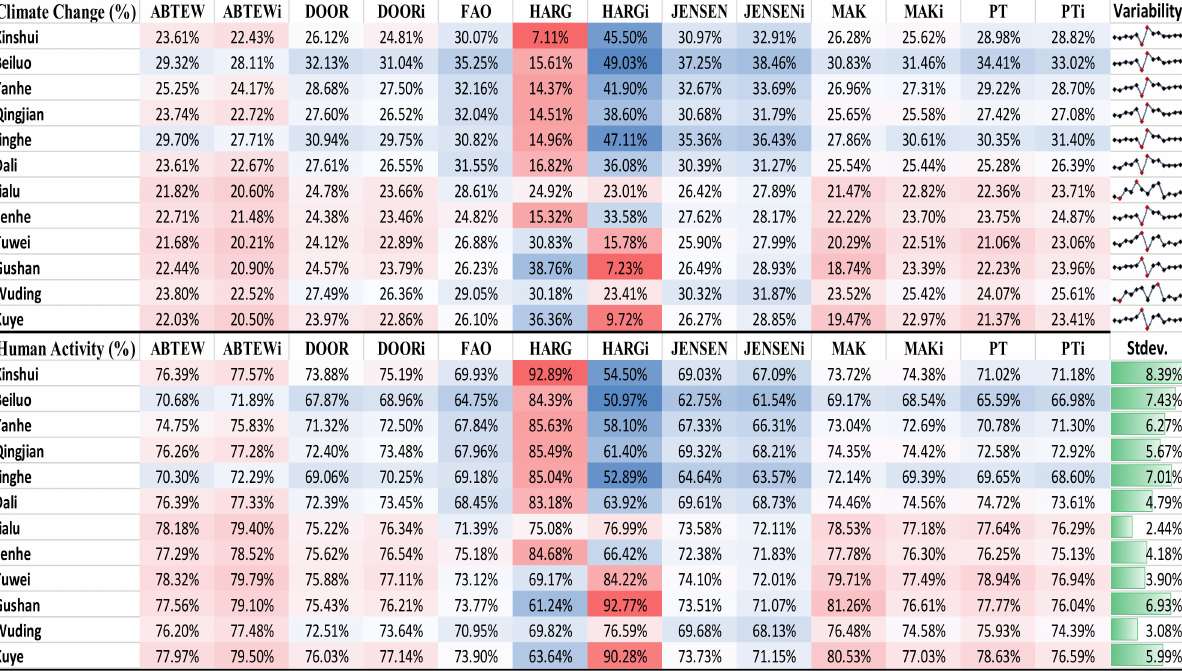
Figure 5. Quantitative contribution to streamflow change by climate change (%) and human activities (%): for each type of 13 E 0 estimations, contribution values are averaged over results calculated with eight Budyko-based methods; at the catchment scale, the variability (line plot) and standard deviation (bar plot) of contribution values derived by different methods are also shown